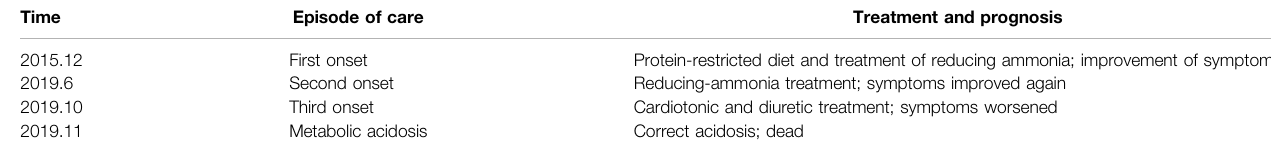
TABLE 1 | The timeline with relevant data from the episode of